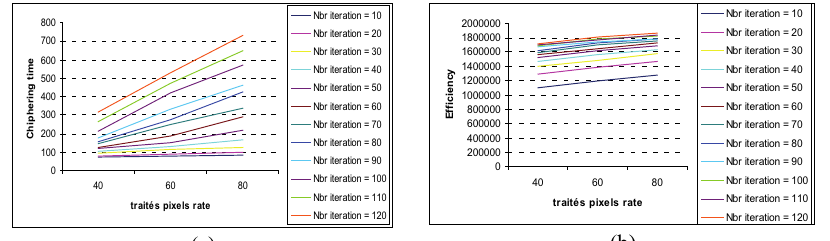
Fig. 3. (a) Variation of ciphering time per iteration according to treated pixels rate, (b) variation of efficiency per iteration according to treated pixels rate.